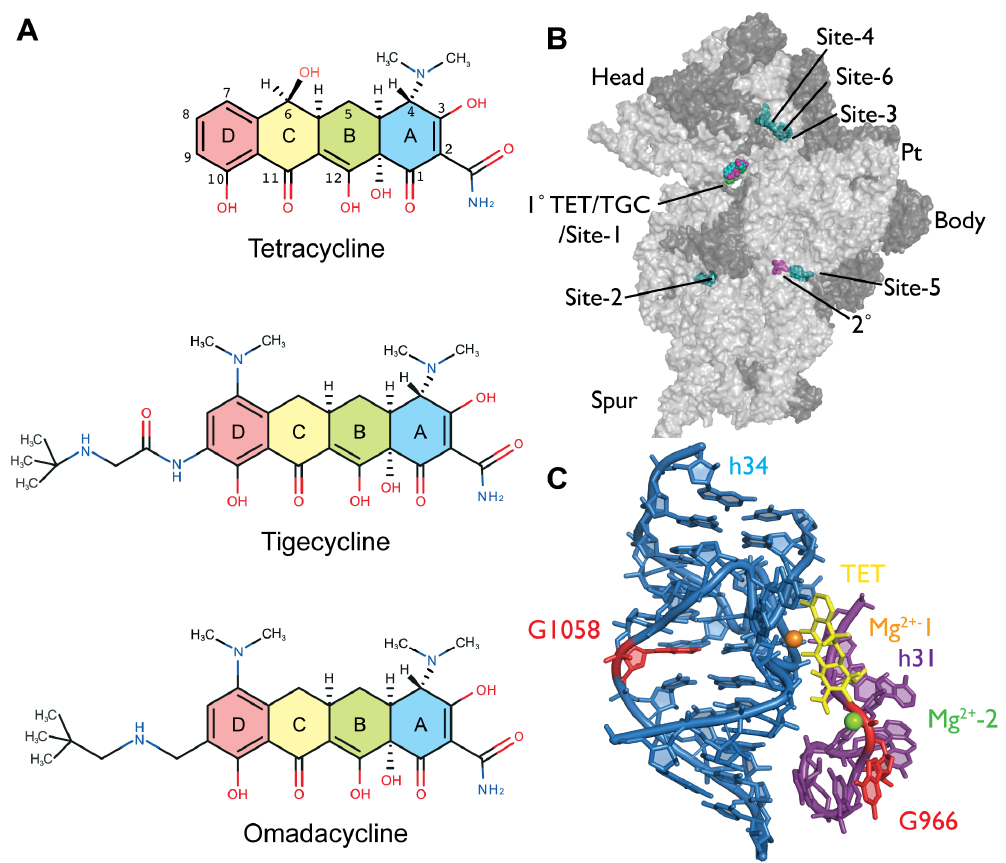
Figure 1. Tetracycline, tigecycline and omadacycline, the tetracycline binding sites and proximity of tetracycline rRNA resistance mutations to the primary binding site. ( A ) The chemical structures of tetracycline, tigecycline, and omadacycline drawn schematically with their common backbone ring structures (rings A–D) colored distinctly. Carbon atom assignments for the 4 ‐ ring backbone are indicated on tetracycline; ( B ) The primary and secondary tetracycline binding sites as observed in X ‐ ray crystallography studies [2–4] are shown on the structure of the 30S ribosomal subunit (rRNA, light grey surface; ribosomal ‐ proteins, dark grey surface). The primary (1°) and secondary (2°) TET binding sites observed by Brodersen et al. are colored pink, the primary (1°) site described by Jenner et al . is green but largely obscured underneath TET, and the TET binding sites 1–6 observed by Pioletti et al . are colored blue and labeled distinctly. The head, spur, platform (Pt) and body 30S subunit landmarks are labeled. ( C ) The primary tetracycline binding site according to Jenner et al. [4] is illustrated showing the two rRNA bases, G1058 and G966, whose mutation results in tetracycline resistance.